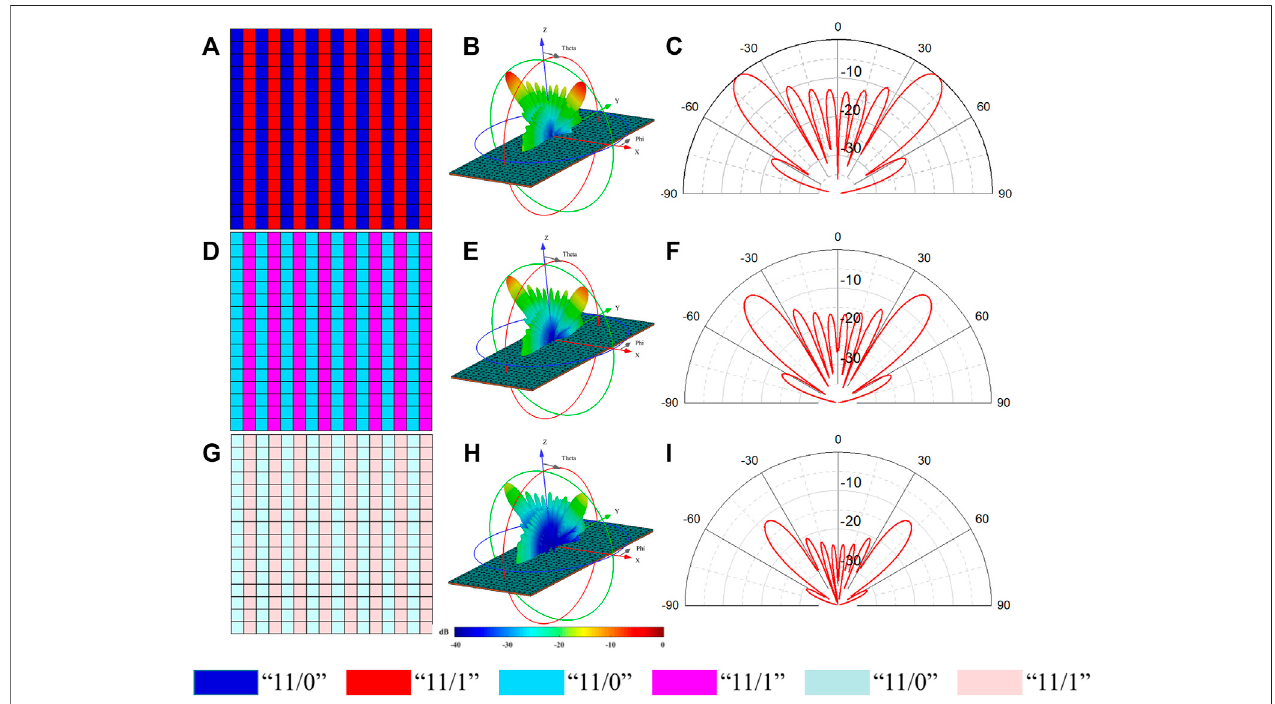
FIGURE6| Coding patterns andsimulatedx-polarized 3Dscattering patterns under they-polarized incidentwaveformanipulationofbeamdirection. (A , D , G) are coding patterns. (B , E , H) are corresponding 3D scattering patterns. (C , F , I) are the 2D scattering patterns at φ = 0 ° .